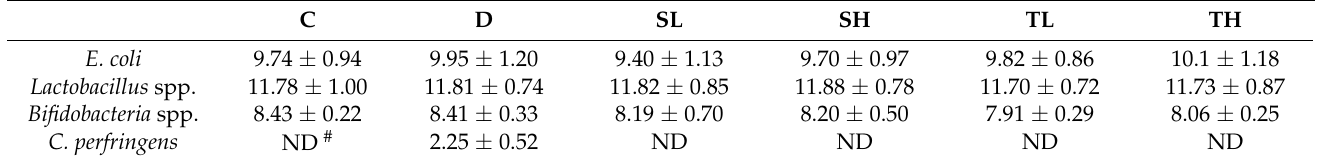
Table 3. Effect of soybeans or tempeh on DMH-induced aberrant crypt foci formation in rat colon. Number of Crypt/ACF